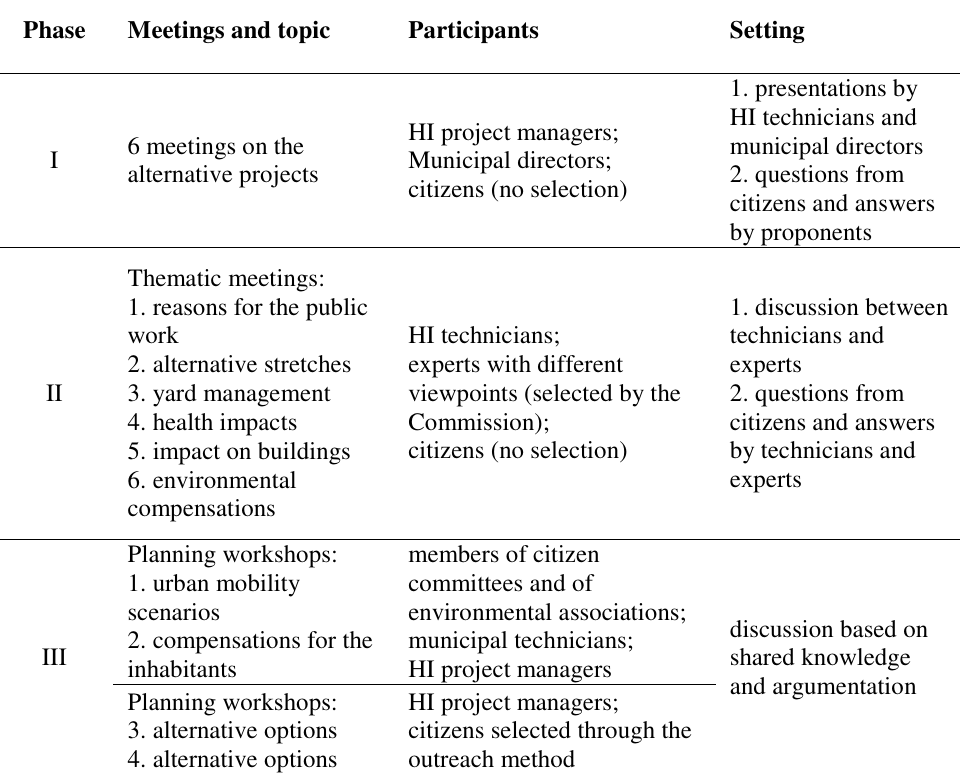
Table 1. The Design of the Deliberative Process in Genoa